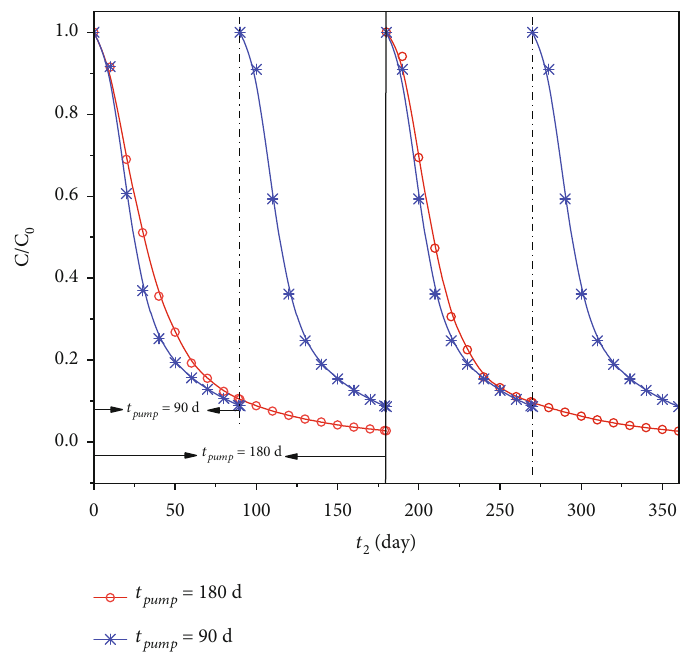
Figure 7: BTCs inside the well with di ff erent pumping frequencies during the pumping